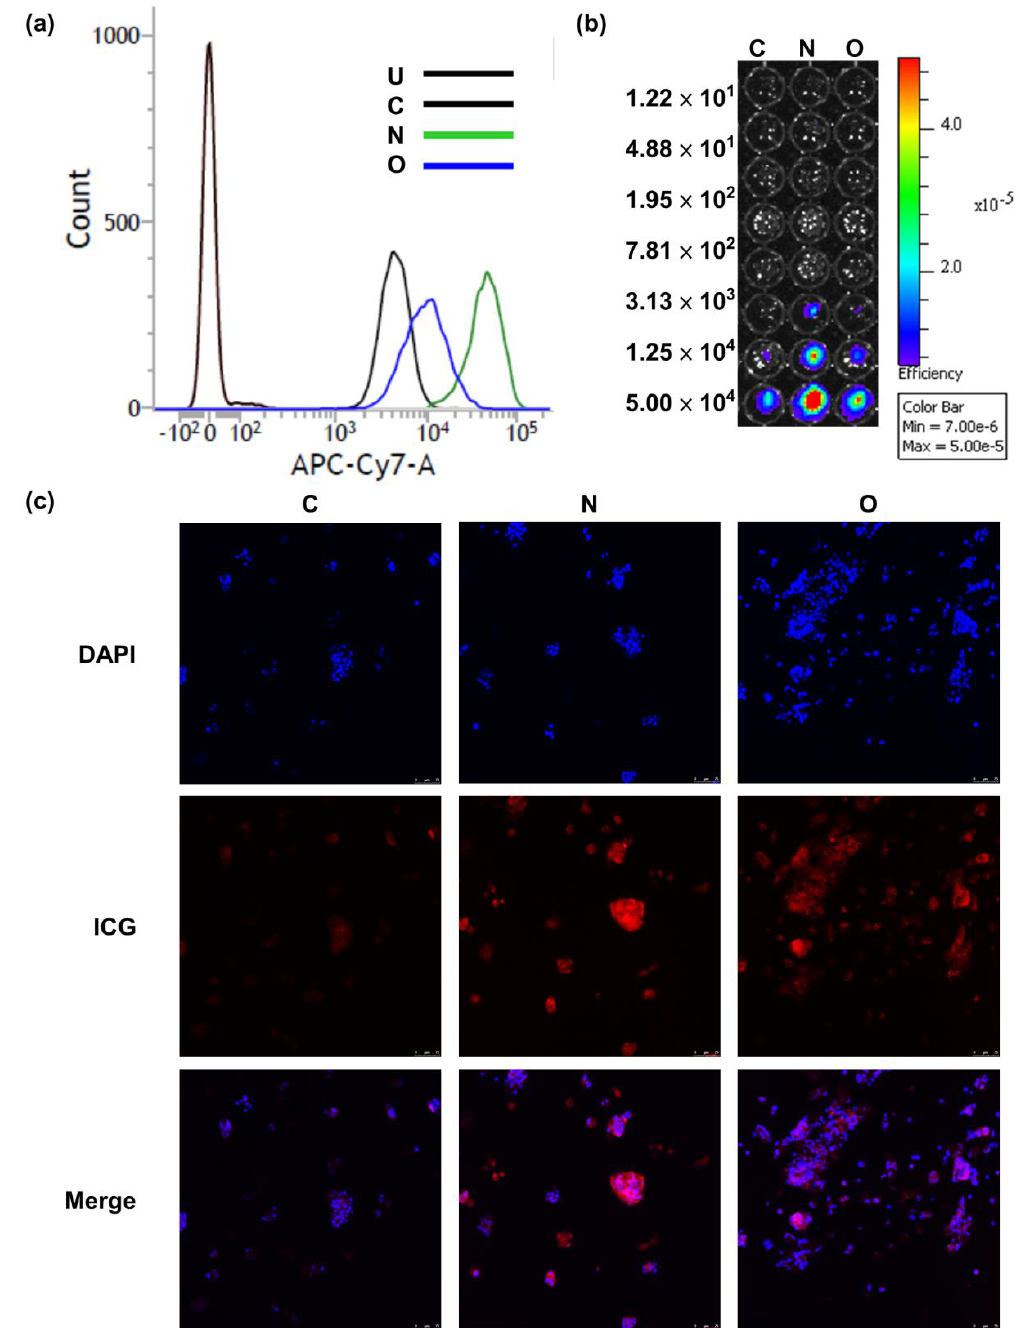
Figure 1. I ndocyanine green (ICG) intake capacity in sodium taurocholate cotransporting polypeptide ( NTCP )-expressing and organic-anion-transporting polypeptide 1B3 ( OATP1B3 )-expressing HT-29 cells. ( a ) The cells were measured by using flow cytometry at the APC-Cy7 wavelength (785 nm) to observe ICG intensity. ( b ) The diluted series cells were detected using an in vivo imaging system (IVIS). ( c ) One hour after ICG was added to the control and the NTCP - and OATP1B3 -expressing HT-29 cells, the cells were monitored under a confocal microscope. C: control HT-29. U: untreated. N: NTCP -expressing HT-29 cells. O: OATP1B3 -expressing HT-29